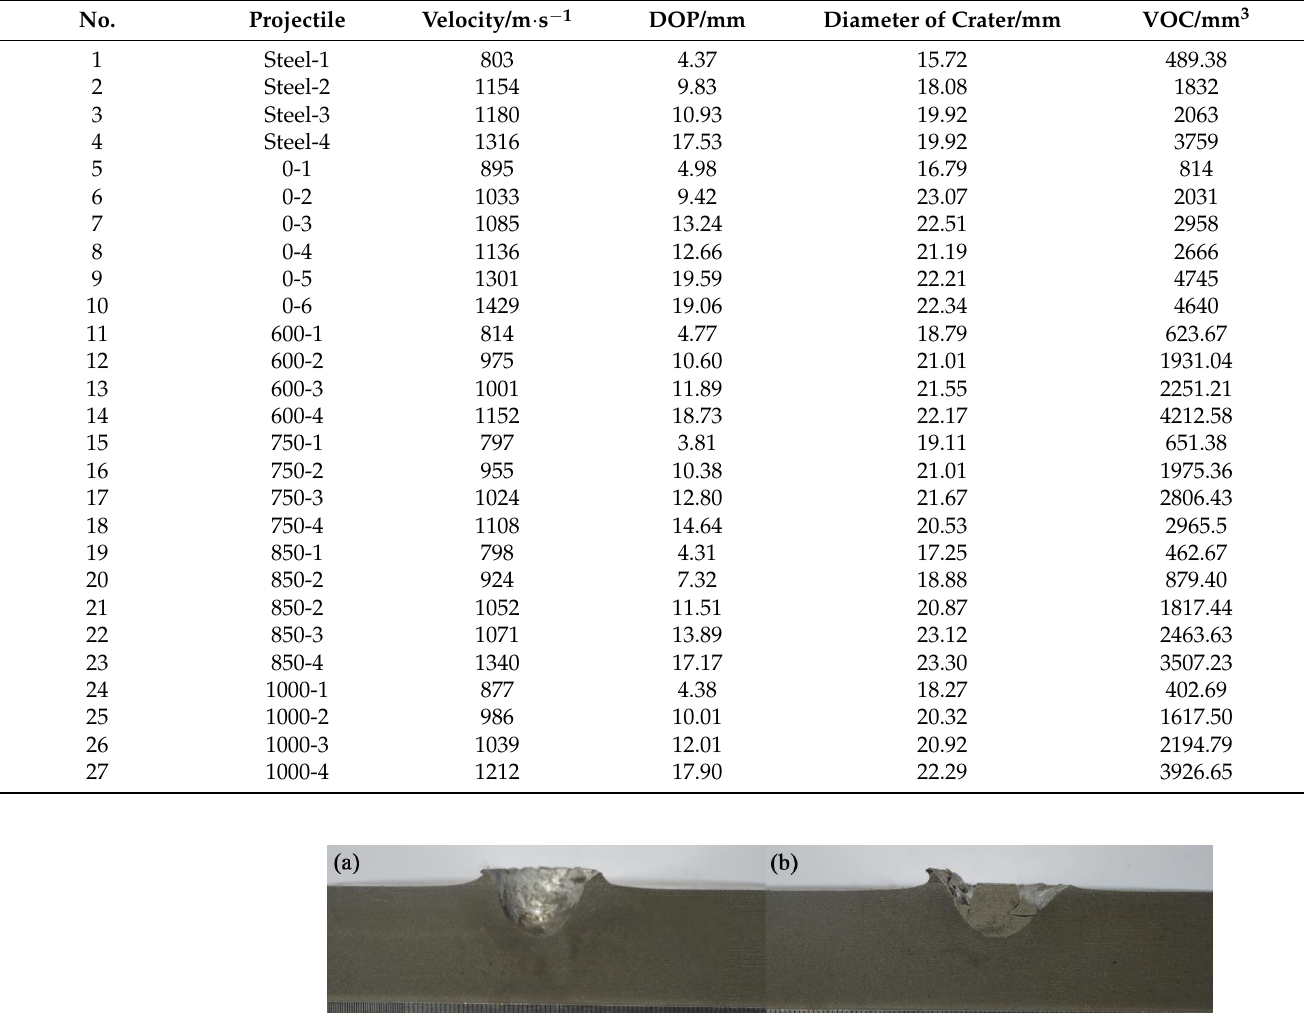
Table 3. Experimental results of the LRPs penetrating the targets.